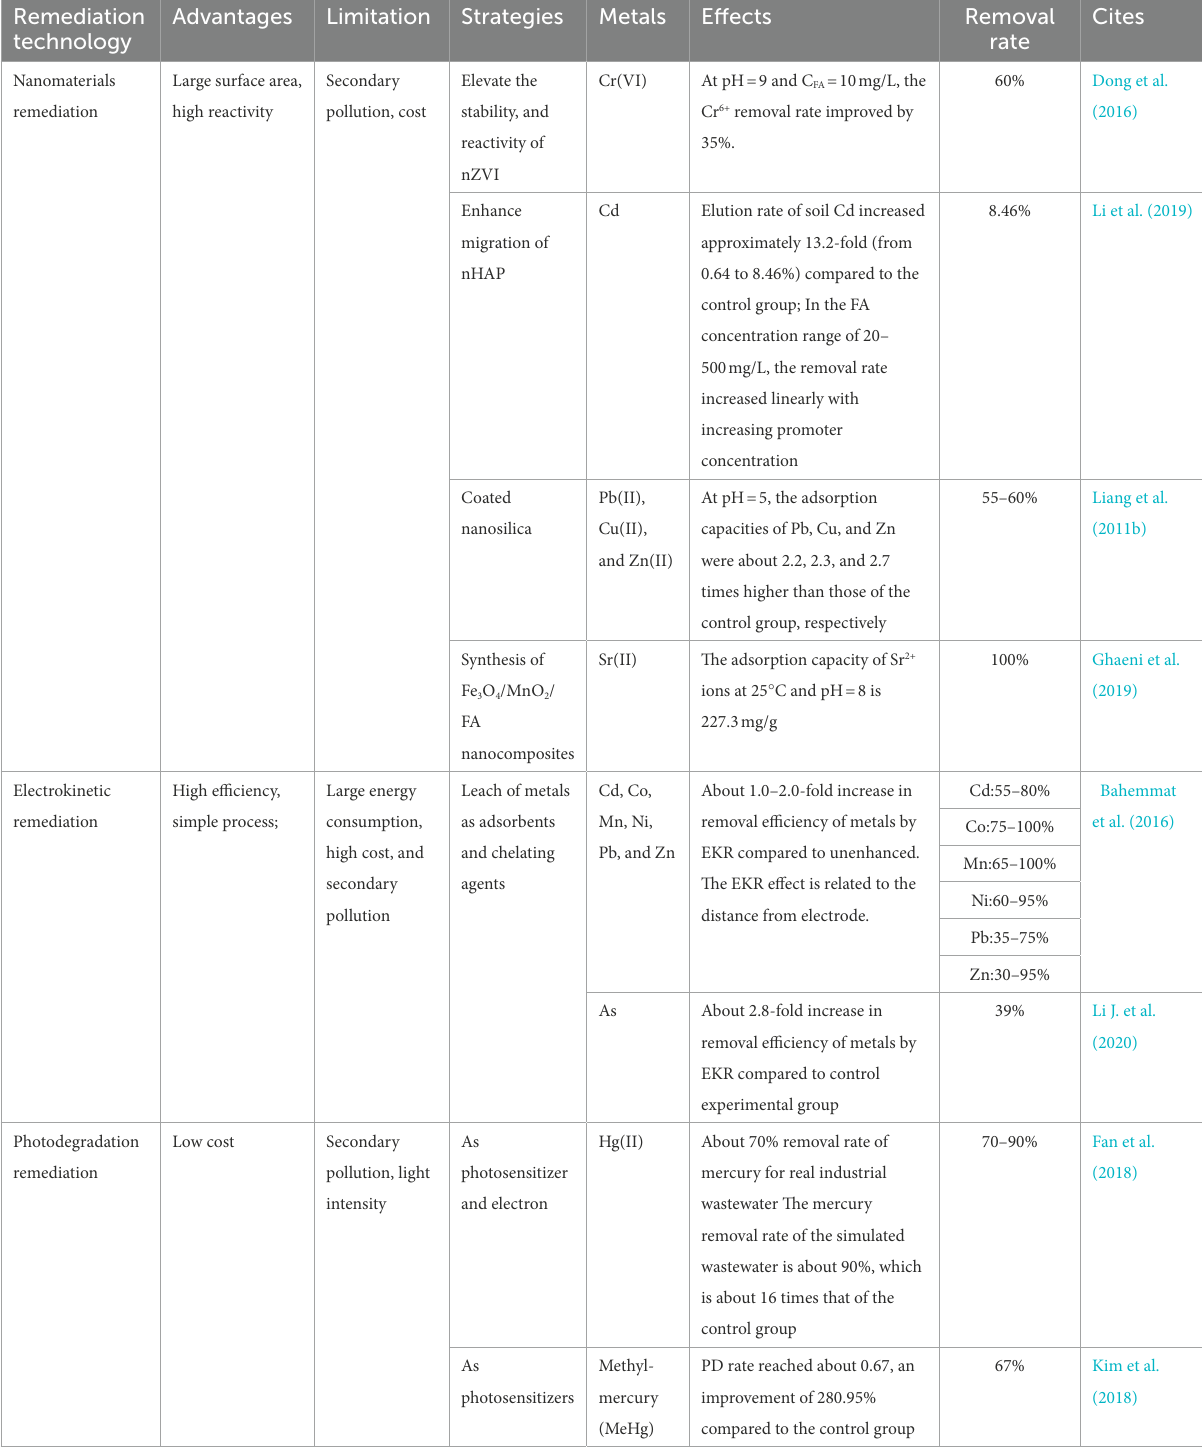
TABLE 1 Impact of FA on physicochemical remediation for metals